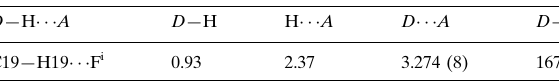
Hydrogen-bond geometry (A˚ , (cid:2)